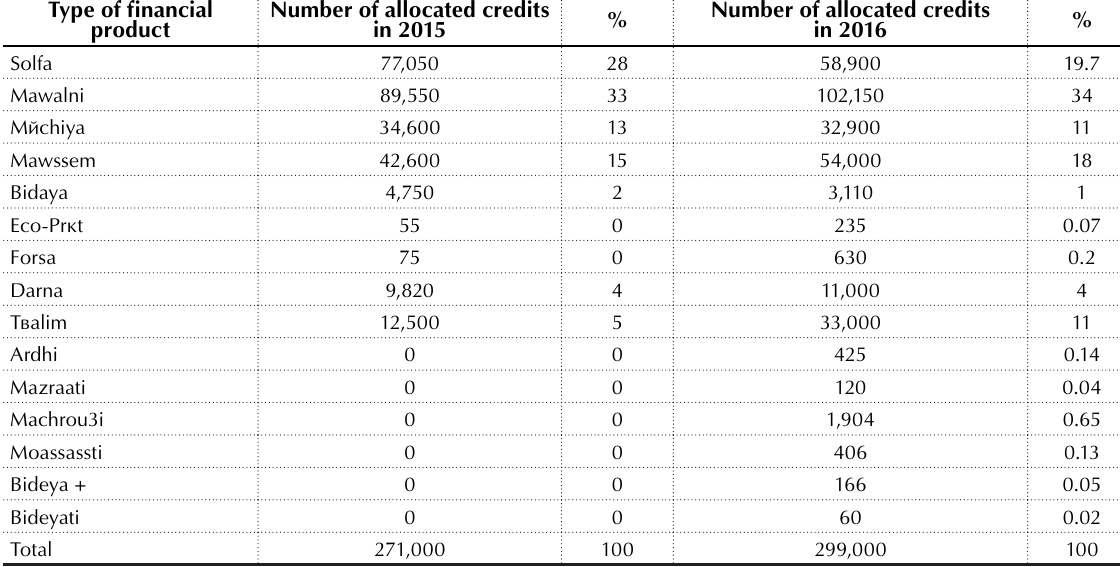
Table 1. ENDA’s distribution of